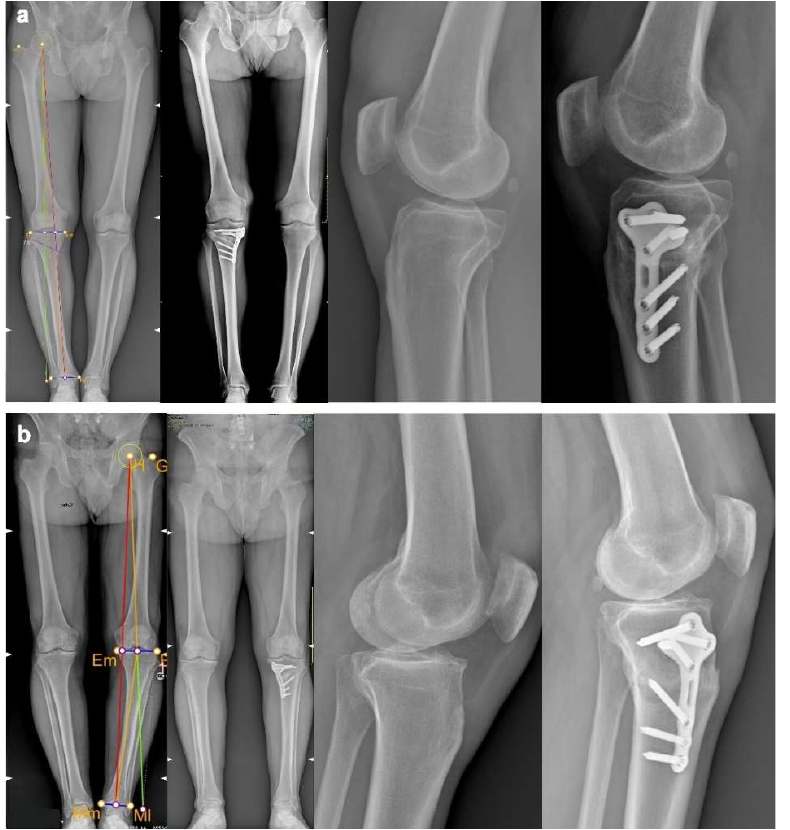
Figure 6. Pre- and postoperative full-length weight-bearing X-ray and lateral knee X-ray of patient 1 ( a ) and patient 2 ( b